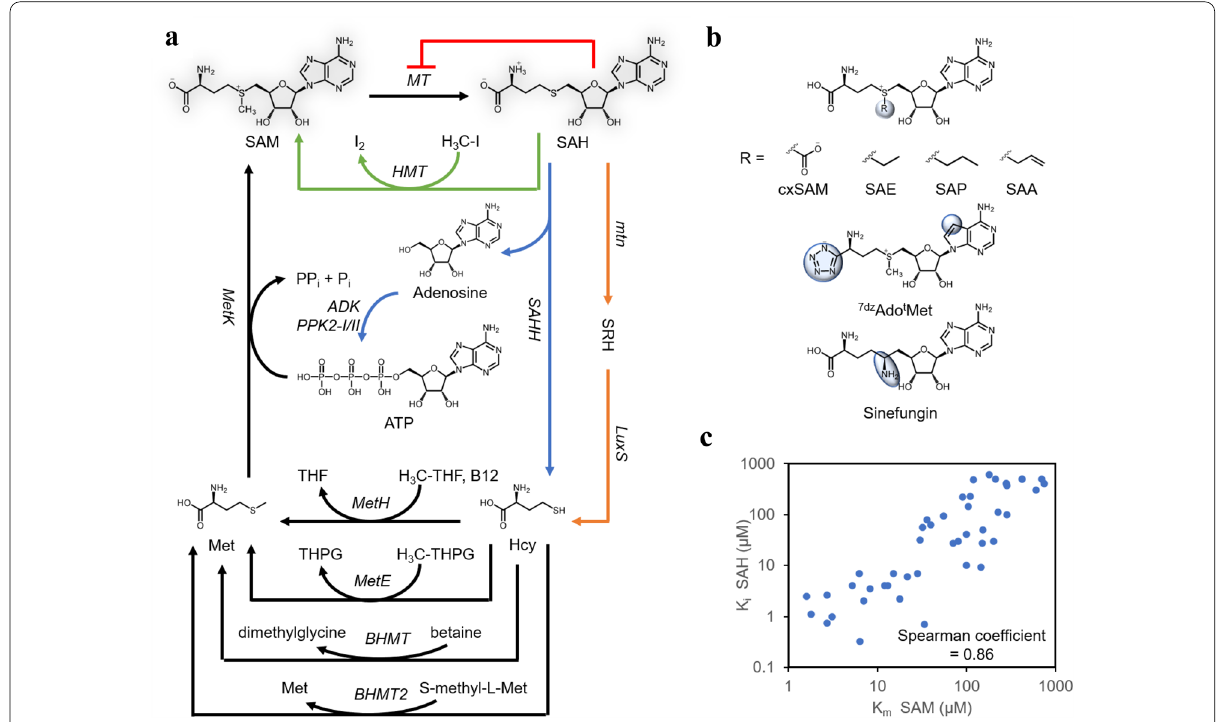
Fig. 6 Co-factors for methyltransferase reaction. a Illustration of SAM regeneration reactions. b Illustration of SAM analogues. c K i of SAH and the K m of SAM for small molecule methyltransferases display a high correlation with spearman coefficient of 0.86 (refer to Table 3 for detailed information). The abbreviations are as follows. SAM, S -adenosylmethionine; SAH, S -adenosylhomocysteine; Met, l -methionine; Hcy, hmocysteine; SRH, S -(5-deoxy- d -ribos-5-yl)- l -homocysteine; THF, Tetrahydrofolate; THPG, tetrahydropteroyltri- l -glutamate; H3C-THF, 5-methyltetrahydrofolate; H3C-THPG, 5-methyltetrahydropteroyltri- l -glutamate; SAE, S -adenosyl- l -ethionine; SAA, S -allyl- l -homocysteine; SAP, S -propyl- l -homocysteine; l - t Met, tetrazole- l -methionine; 7dz ATP, 7-deaza-ATP; Pi, phosphate; PPi, pyrophosphate; MT, methyltransferase; HMT, halide methyltransferase; SAHH, SAH hydroxylase; Mtn, SAH nucleosidase; LuxS, S -ribosylhomocysteine lyase; metH, cobalamin (or viatamin B12)-dependent methionine synthase; metE, cobalamin (or viatamin B12)-independent methionine synthase; BHMT, Betaine–homocysteine S-methyltransferase 1; BHMT2, S -methylmethionine– homocysteine S-methyltransferase; ADK, adenosine kinase; PPK2-I/II, polyphosphate kinase; metK, S -adenosylmethionine